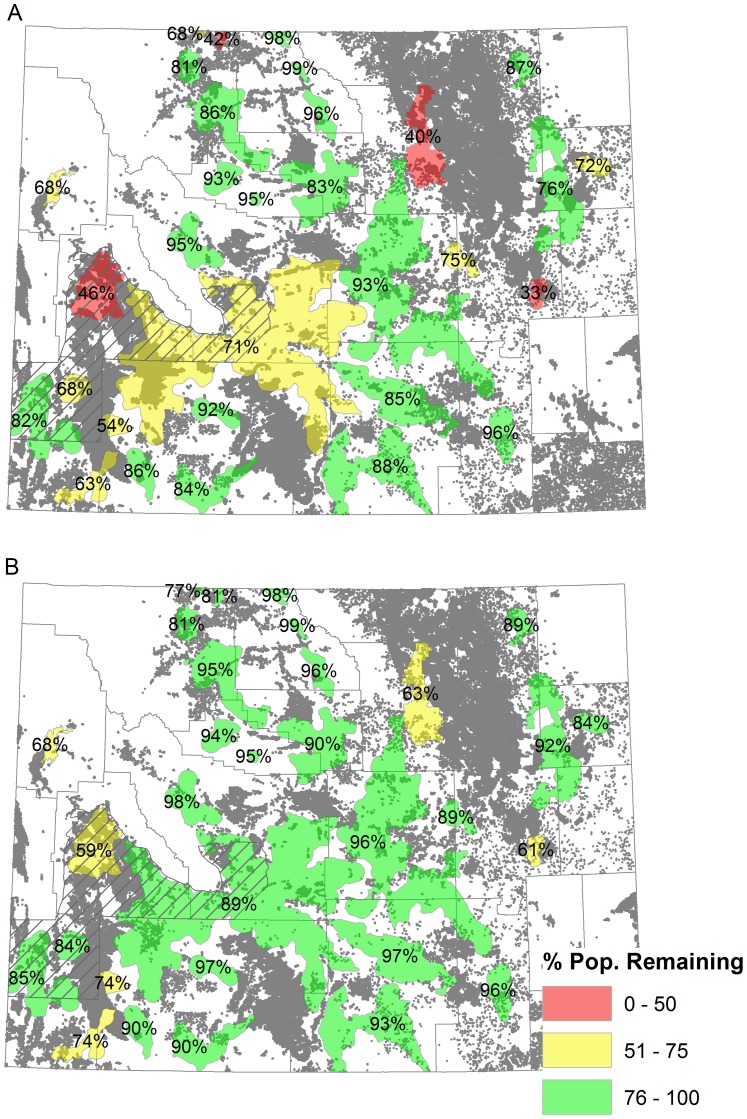
The percent of the sage-grouse population remaining under the long-term scenario with and without conservation.
Figure 5A represents the population remaining from current in each core area and the build-out features shown as gray dots under the long-term scenario with no conservation. Figure 5B shows the percent of the sage-grouse population remaining from current in each core area and the build-out features shown as gray dots under the long-term scenario with the core area strategy in place. The NRCS easement priority area is shown in hatched shading, and county outlines in gray.